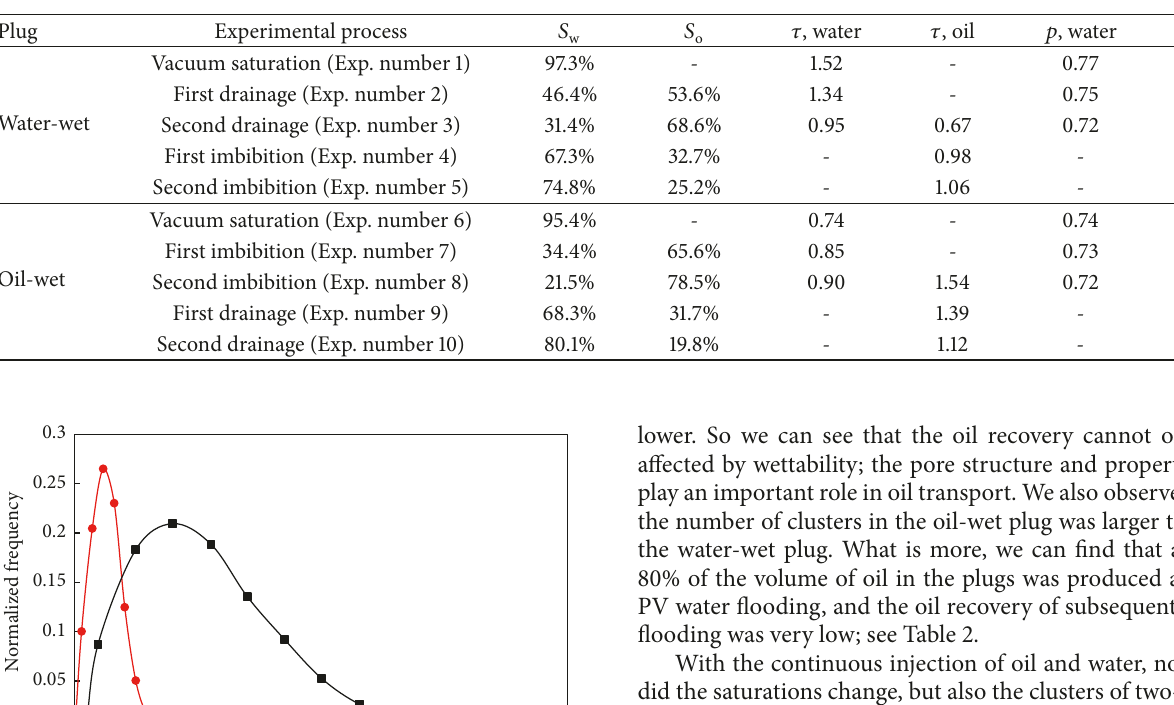
Table 2: Statistical parameters associated with the fluid clusters for the two plugs.